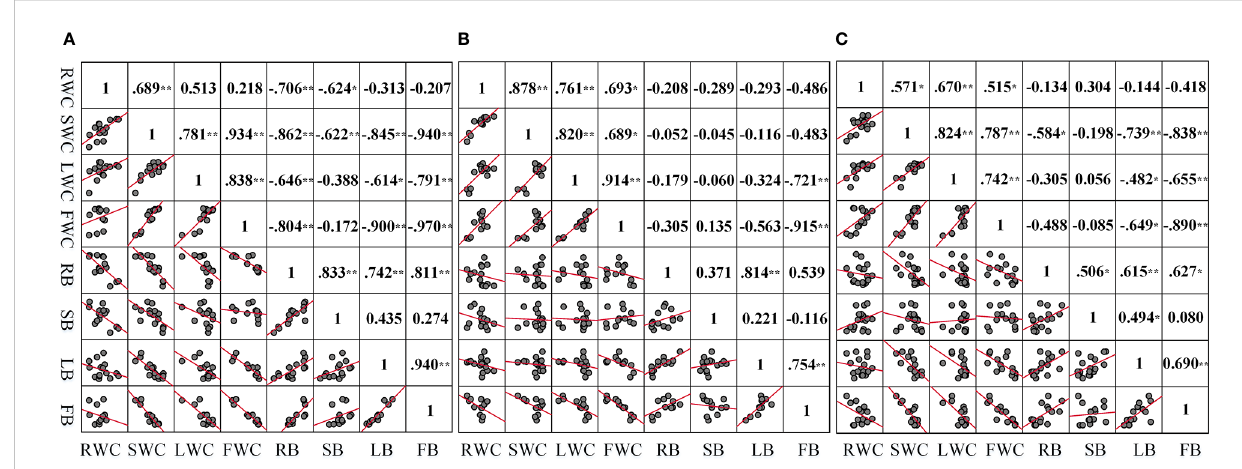
FIGURE 8 Correlation between the water content and biomass of each organ under different drought conditions (A – C) are the correlation between the water content and biomass of each component organ in LD, MD, and CS, respectively. *p<0.05; * *p< 0.01.